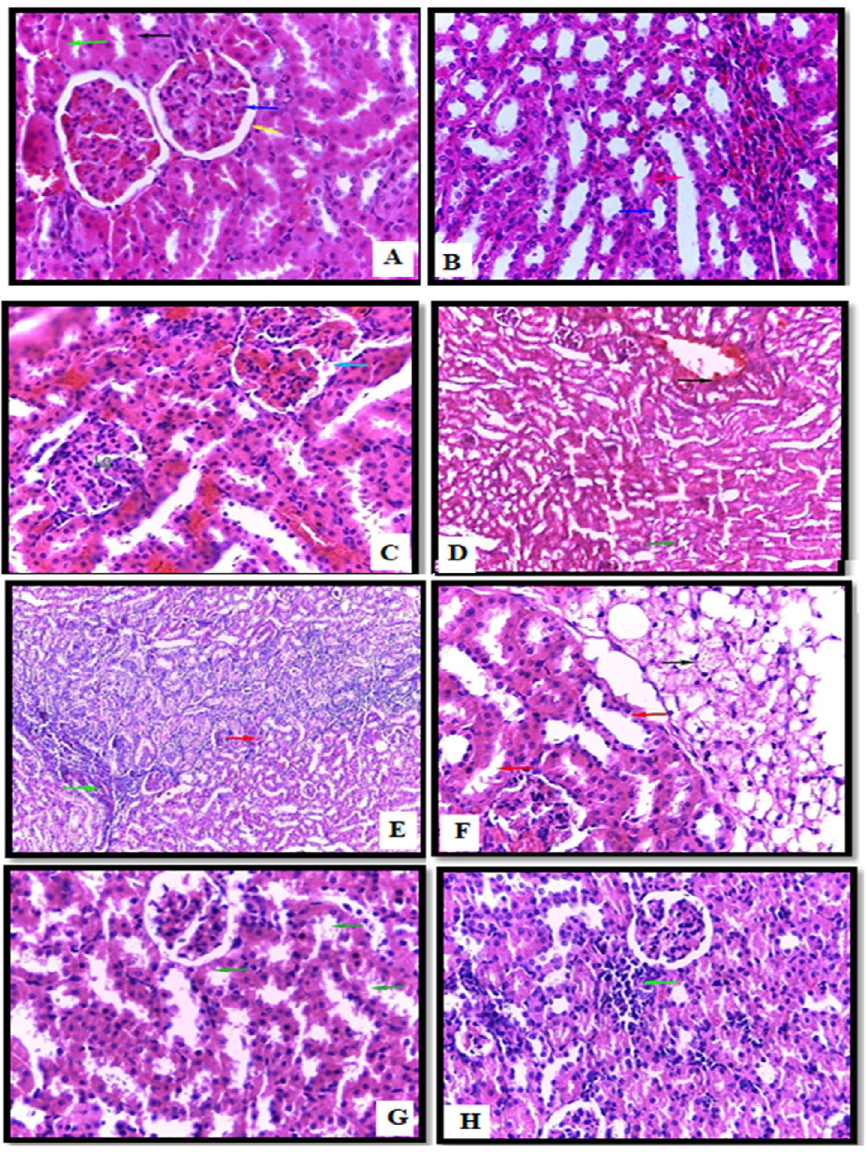
Fig. 3. Photomicrograph of HE stained kidney sections from rats A- B: Controlshowing normal tubular epithelial cell, no necrosis noted; C- necrosis in some tubule urinary, renal glomeruli and bleeding with the degeneration of Bowman glomerulus; D- decomposition of urinary tubules decomposition of Bowman and lobulated glomerulus and Haemosidrin; E- the inflammatory response and hemorrhage; F- increase in adipose tissue and necrosis in some tubule urinary; G- H the cells organized around the normal shape and the absence of inflammatory cells. (Magnifications, all 470